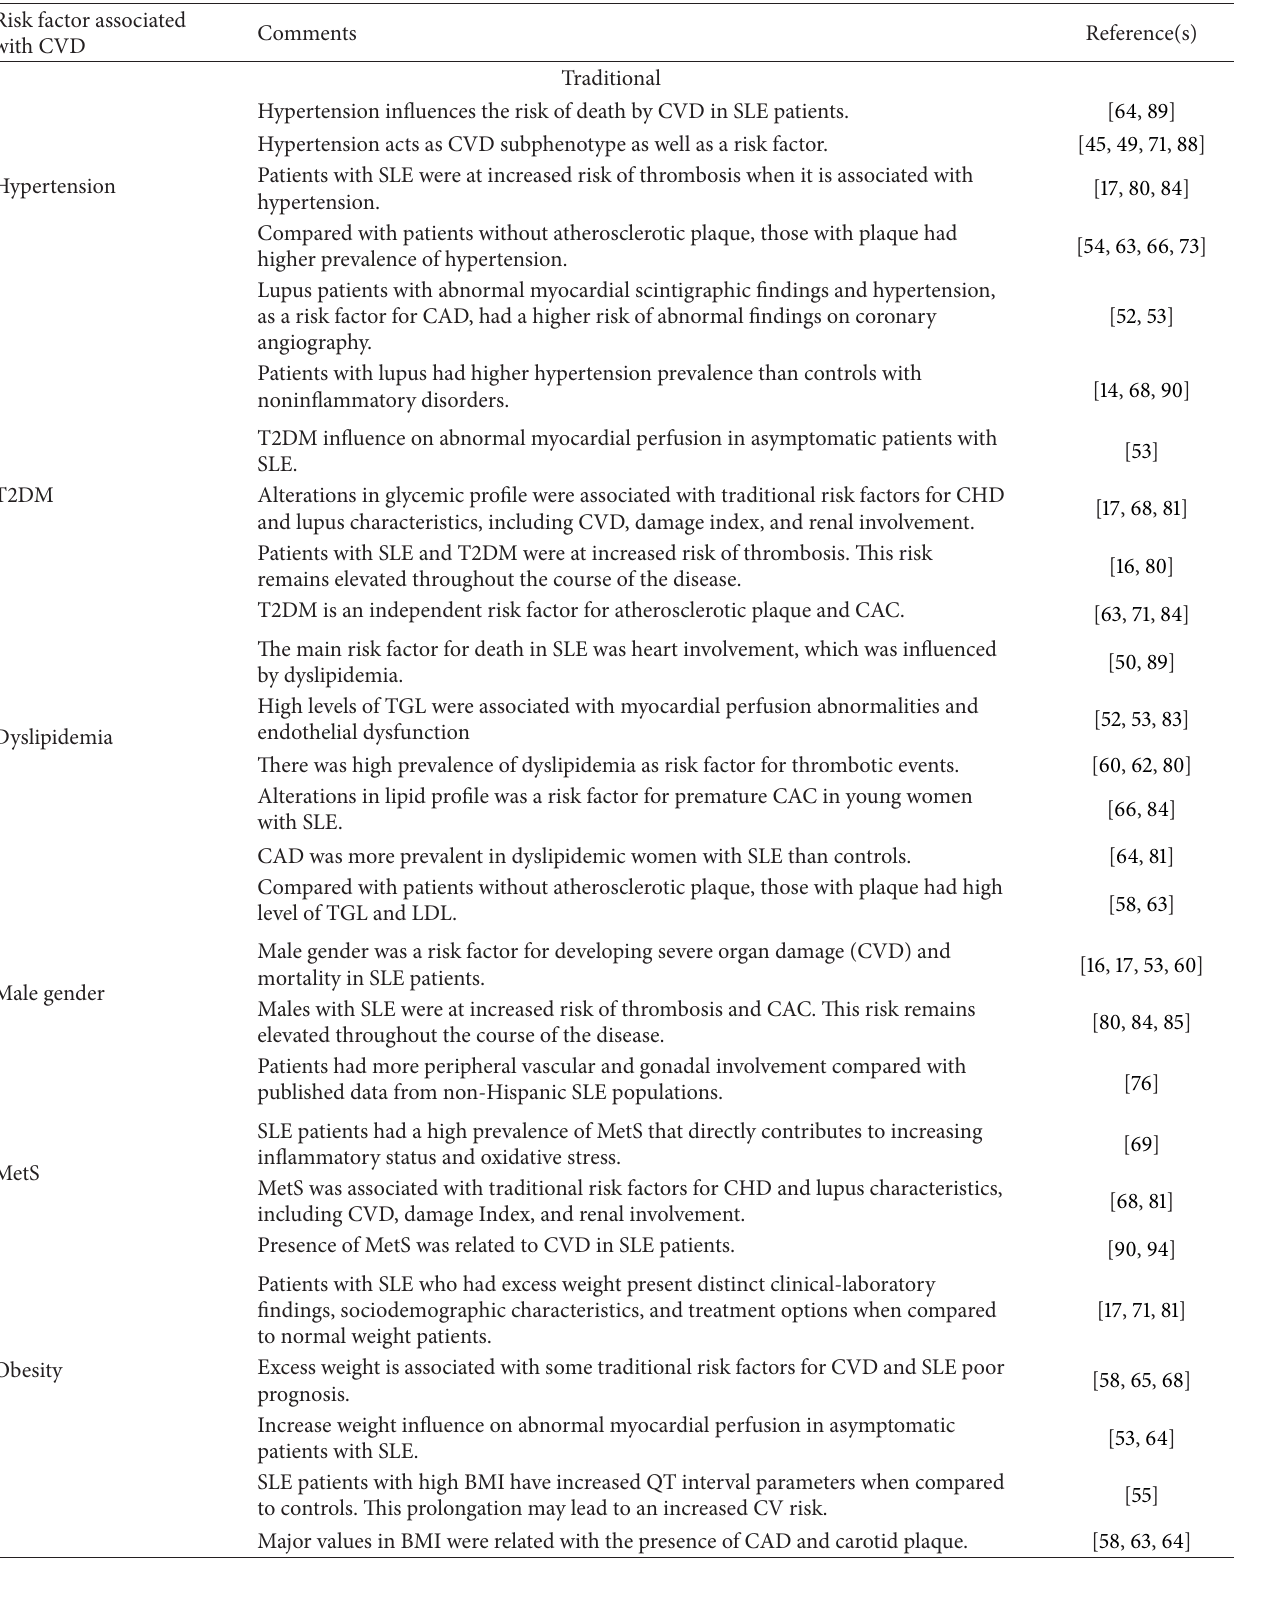
Table 6: Traditional and nontraditional risk factors associated with cardiovascular disease and systemic lupus erythematosus in Latin